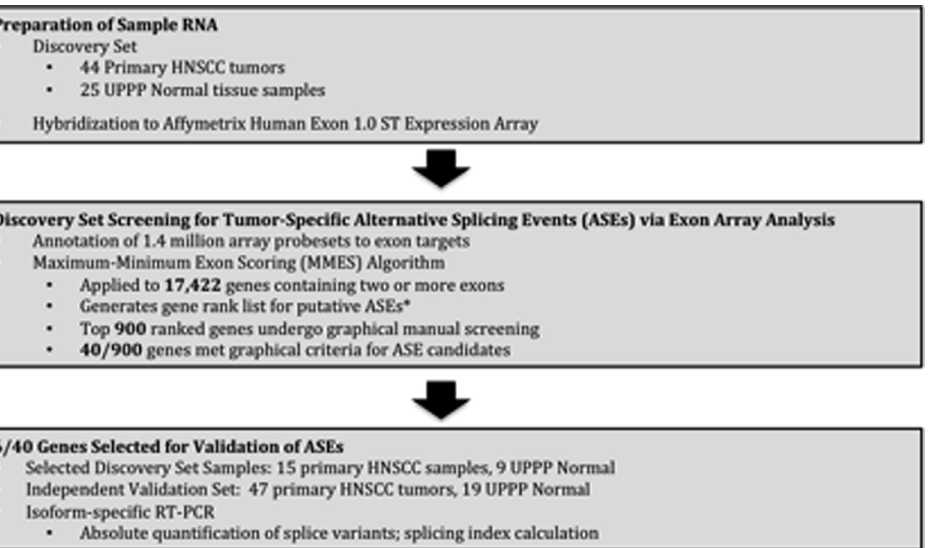
Figure 1. Figure 1 demonstrates the experimental flow from tissue procurement to validation of tumor-specific alternative splicing events in our study.